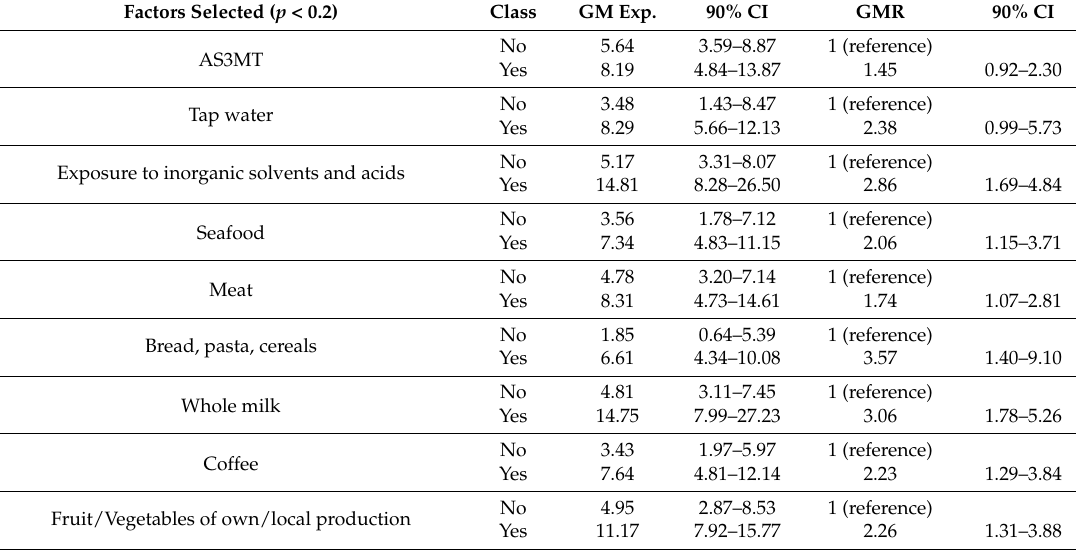
Table 6. Taranto sample. Factors associated with u(iAs+MMA+DMA) concentration by stepwise multivariate regression.